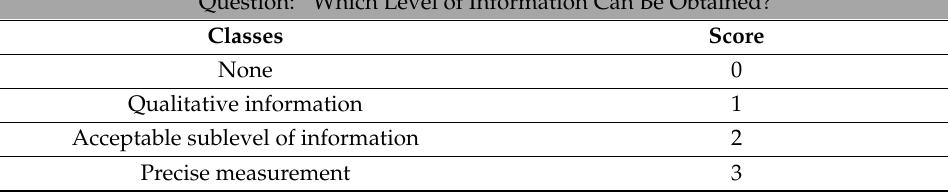
Table 2. LoI sr,pa —obtainable level of information.